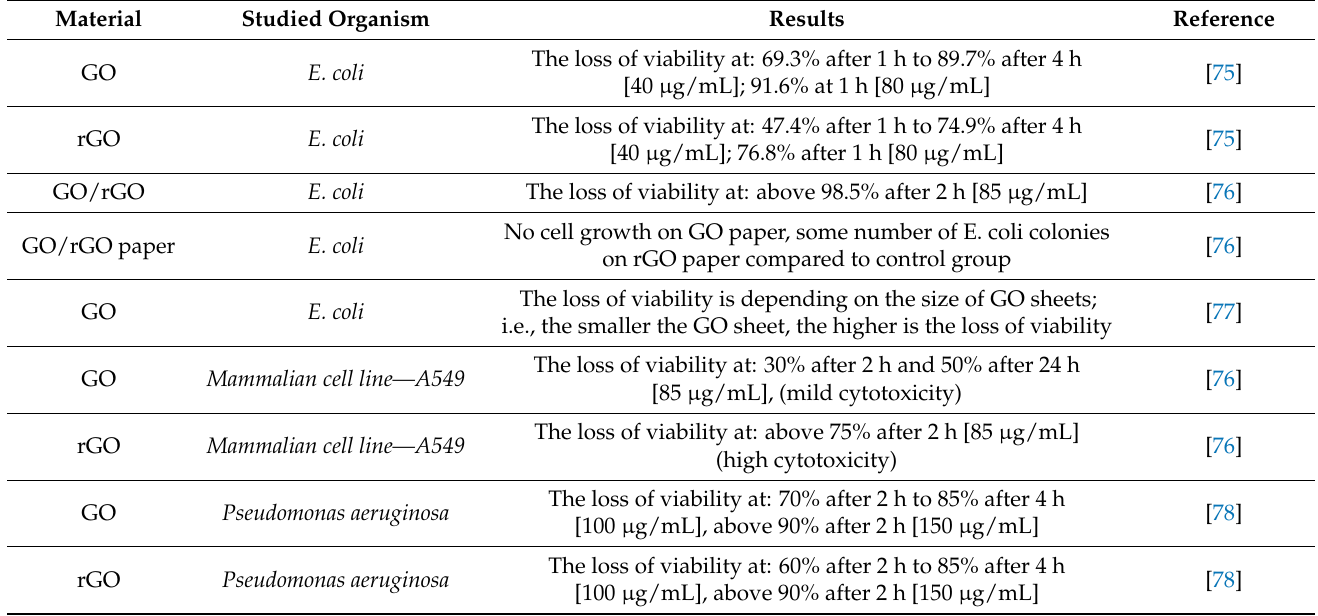
Figure 4. SEM images of E. coli bacteria in ( a , b ) saline solution, ( c , d ) in GO dispersion (40 µg/mL) , ( e , f ) in rGO dispersion (40 µg/mL) after 2 h incubation. Reprinted with permission from [75] . Cop- yright 2011 American Chemical Society.